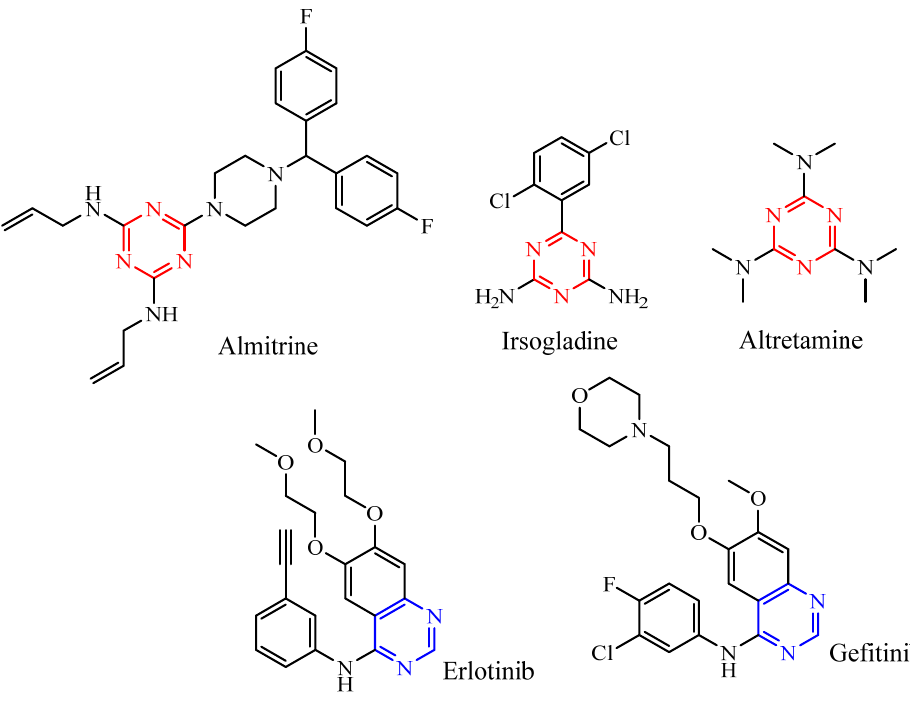
Figure 1. Examples of drugs in the 1,3,5-triazines and pyrimidines series.